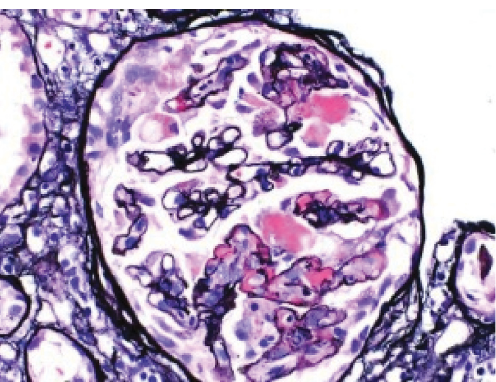
Figure 2: Light microscopy showing diffuse cellular crescent formation.